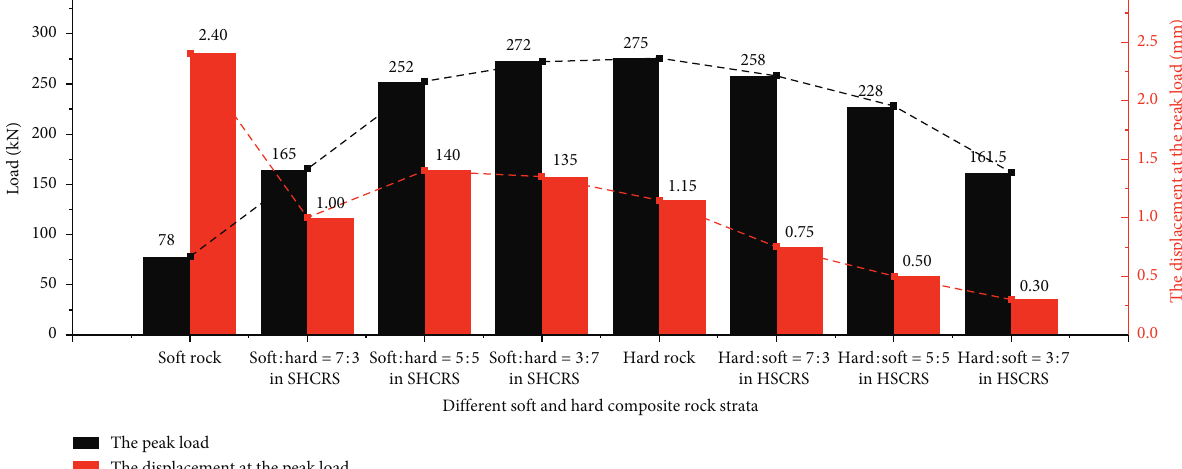
Figure 19: The peak load and the displacement at the peak load comparison under different soft and hard composite rock